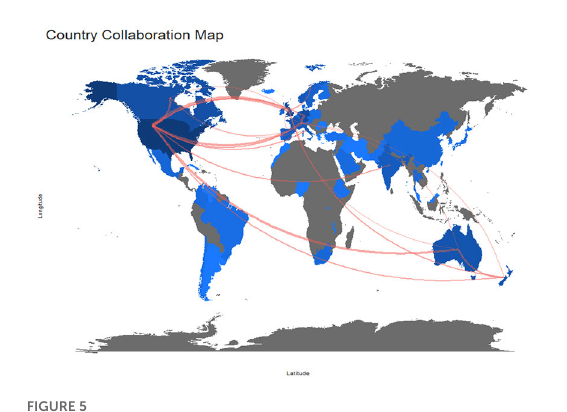
FIGURE5 Map of international collaborations between 2000 and 2019. Every line represents a collaboration between institutions in two different countries. To better illustrate the pattern, only national collaborations with more than 10 joint publications in both decades are shown. The color intensity of blue is proportional to the number of publications of the country. Countries in gray did not publish any article that references To Err Is Human